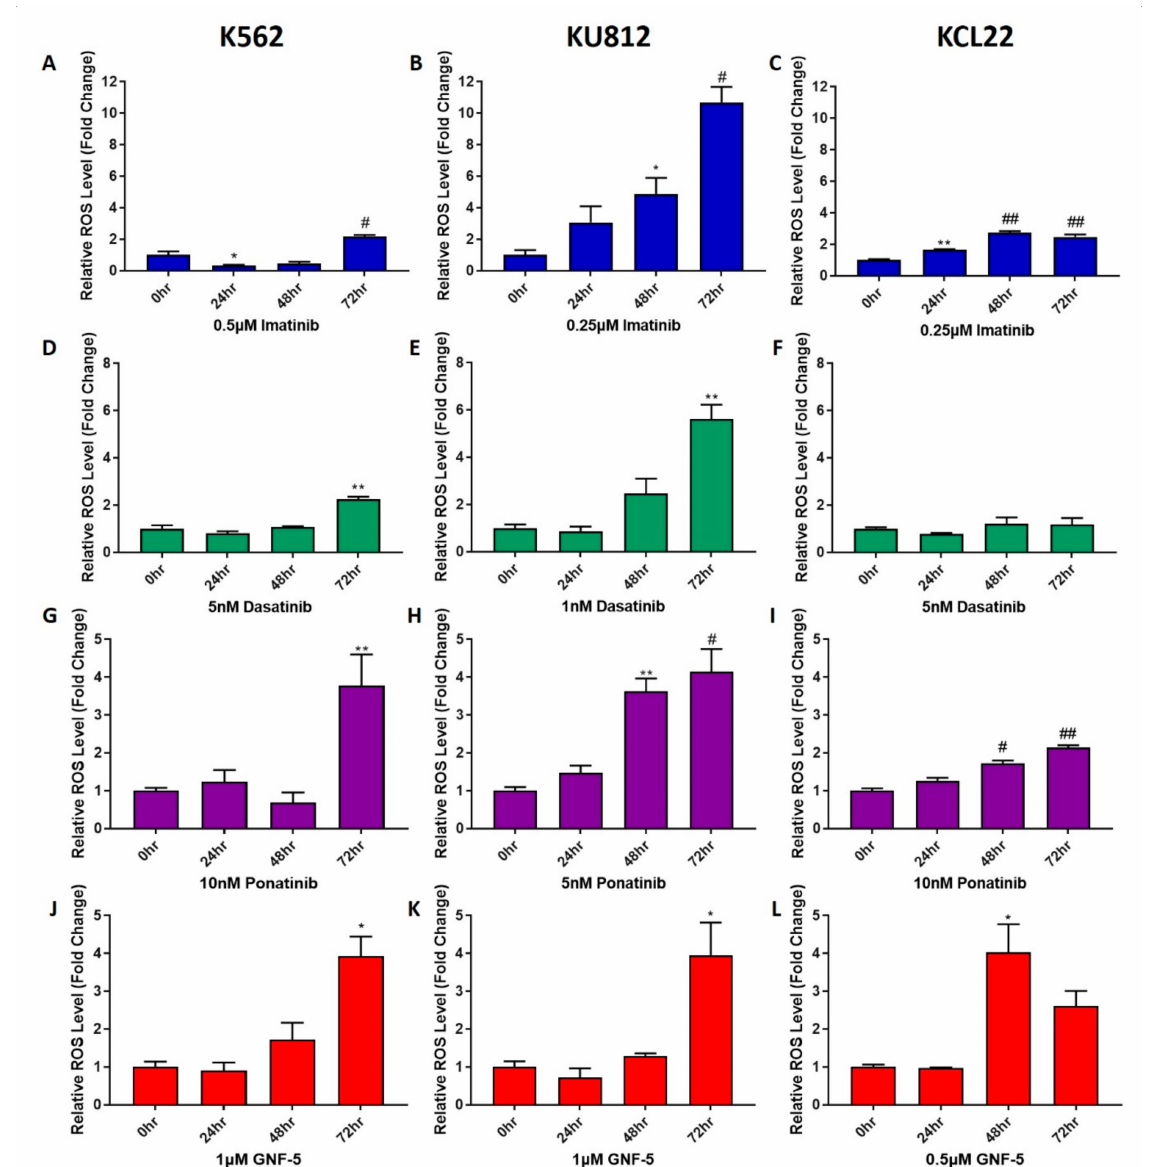
Figure 3. TKIs increase ROS levels in CML cells. K562, KU812 and KCL22 CML cells were treated with either imatinib ( A – C ), dasatinib ( D – F ), ponatinib ( G – I ) or GNF-5 ( J – L ) for 24, 48 or 72 h. Following this, ROS level assays were performed and these data are displayed in the figure. Results were analyzed via one-way ANOVAs with a Dunnett’s post hoc test. Statistical tests compared results between the treated cells and the untreated control. * = p < 0.05, ** = p < 0.01, # = p <0.001, ## = p < 0.0001. n = 3. Values displayed as mean ±